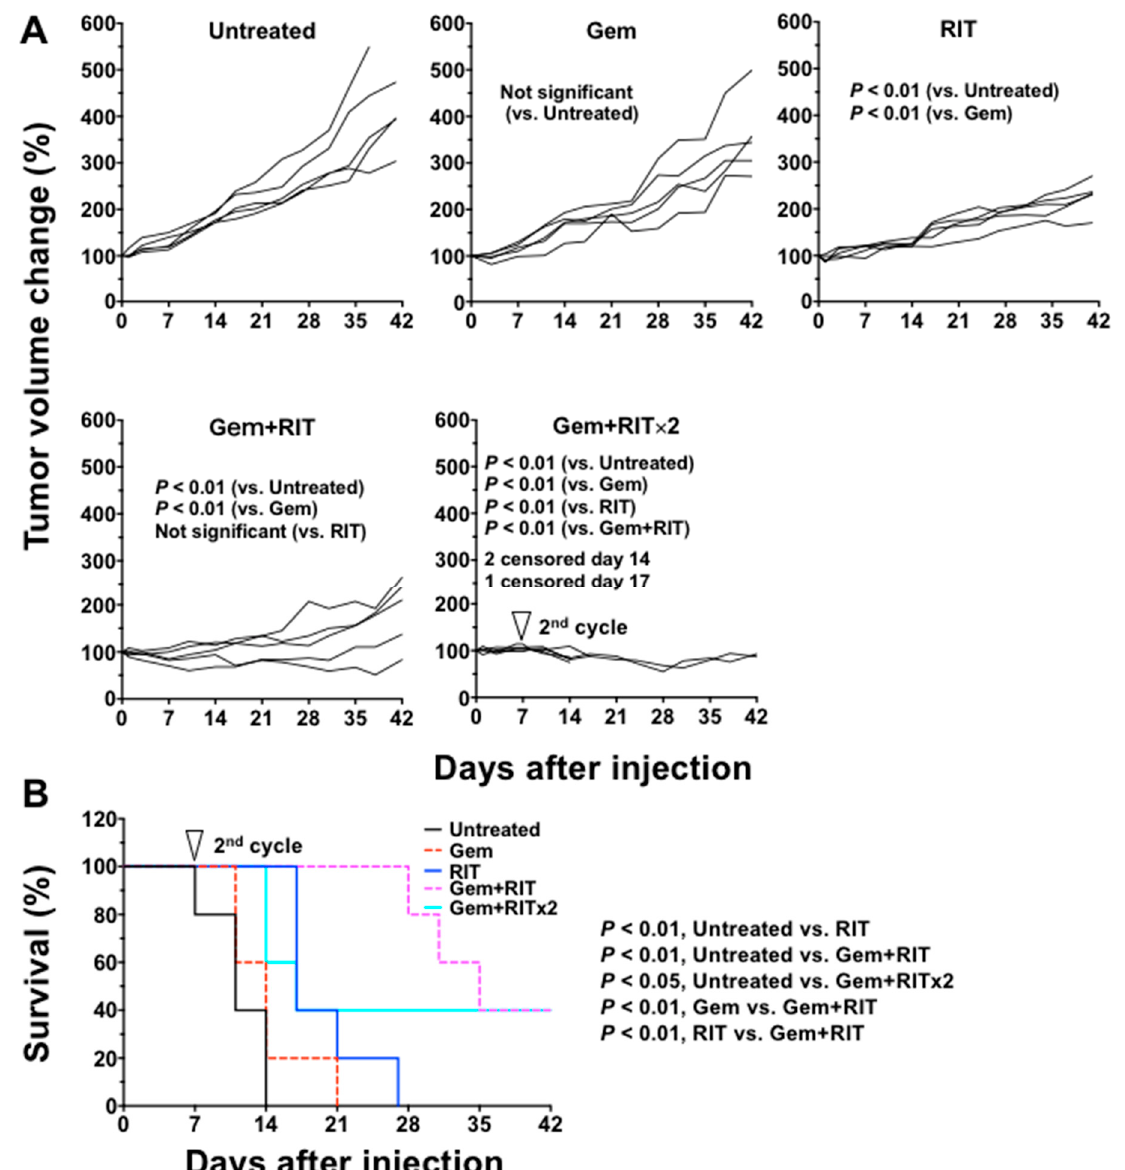
Figure 5. Individual tumor growth curves of BxPC-3 tumors in mice treated with single and combination regimens. The mice were injected with gemcitabine (gem, 240 mg/kg body weight) alone, 3.7 MBq of 90 Y-labeled anti-CD147 antibody 059-053 (RIT) alone, and the combination of gem plus RIT (one and two cycles) shown in the ( A ). Tumor size was measured at least twice a week. Survival curves were plotted based on the endpoint of 150% tumor volume ( B ).